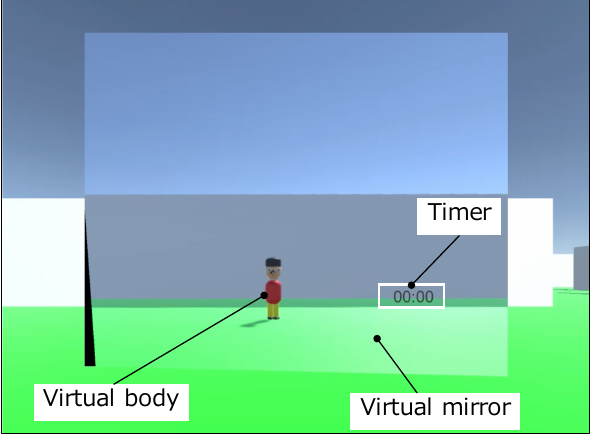
Figure 12. The visual field image presented on the